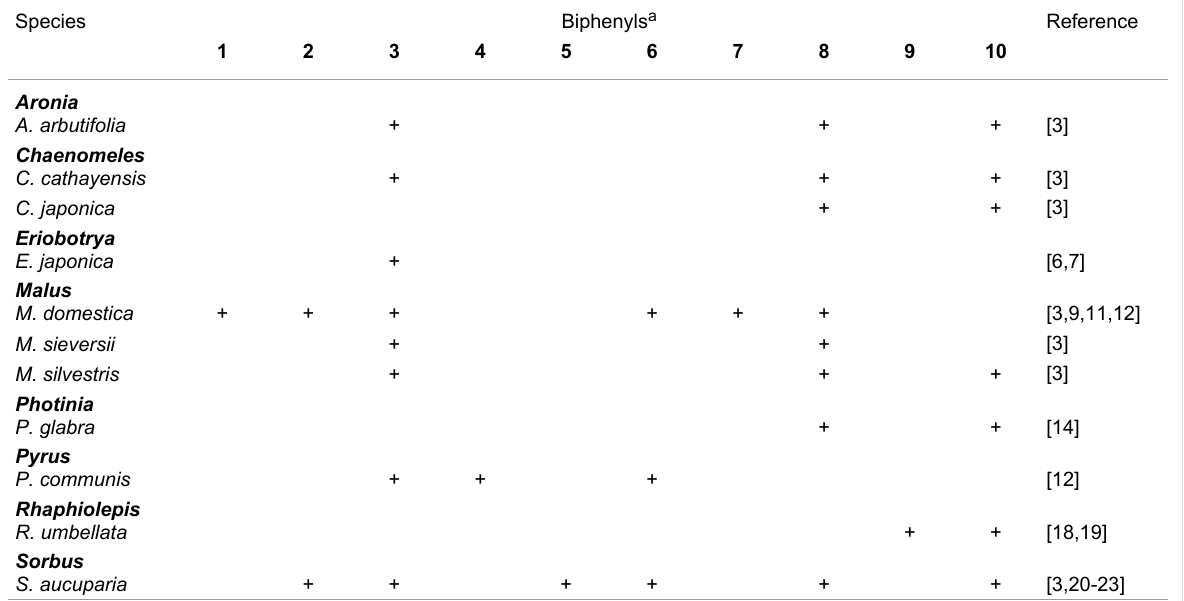
Table 1: Occurrence of biphenyl phytoalexins in species of the Pyrinae. Species Biphenyls